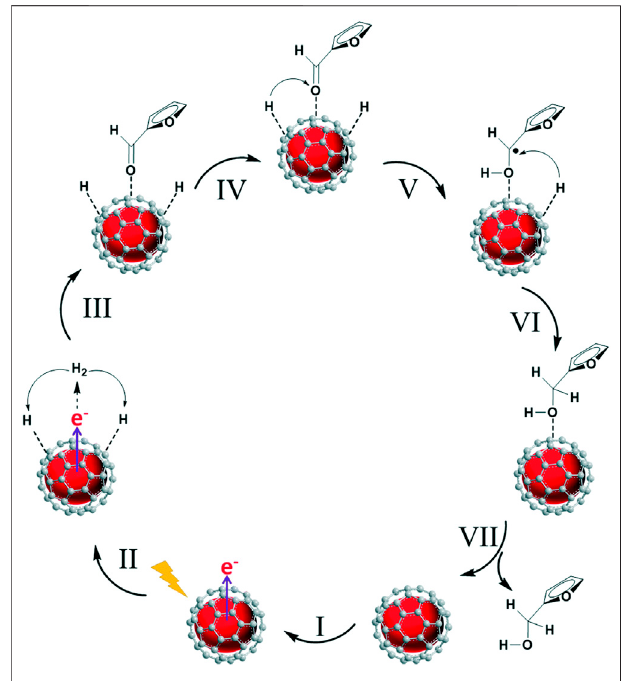
Frontiers in Chemical Engineering |